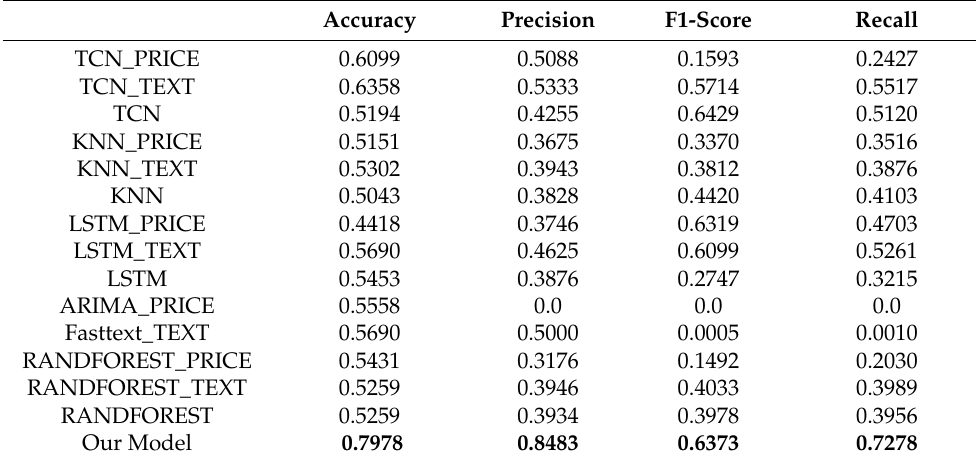
Table 2. Results compared with benchmarks. The suffix PRICE in the First column means that input only contains price The suffix TEXT means that the input only contains Text information, and no suffix means that the combination of the two is used.